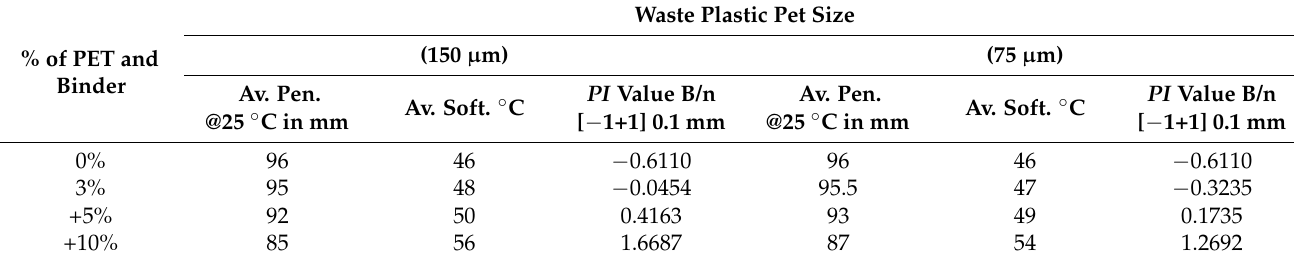
Table 3. Effect of PET content and size on PI